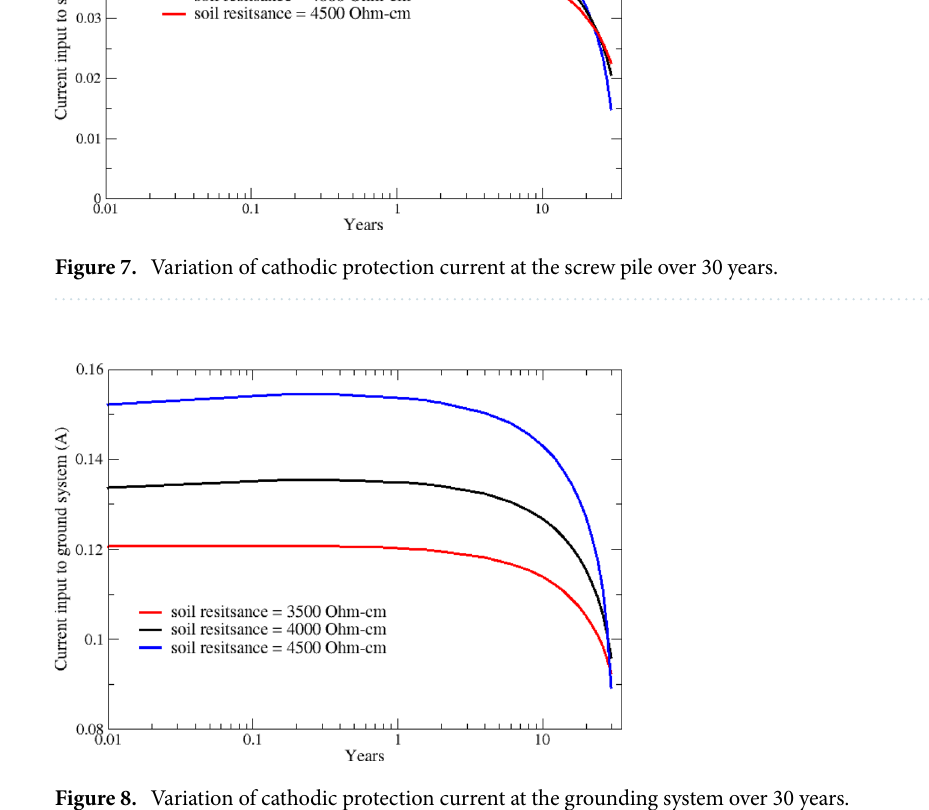
Figure 8. Variation of cathodic protection current at the grounding system over 30